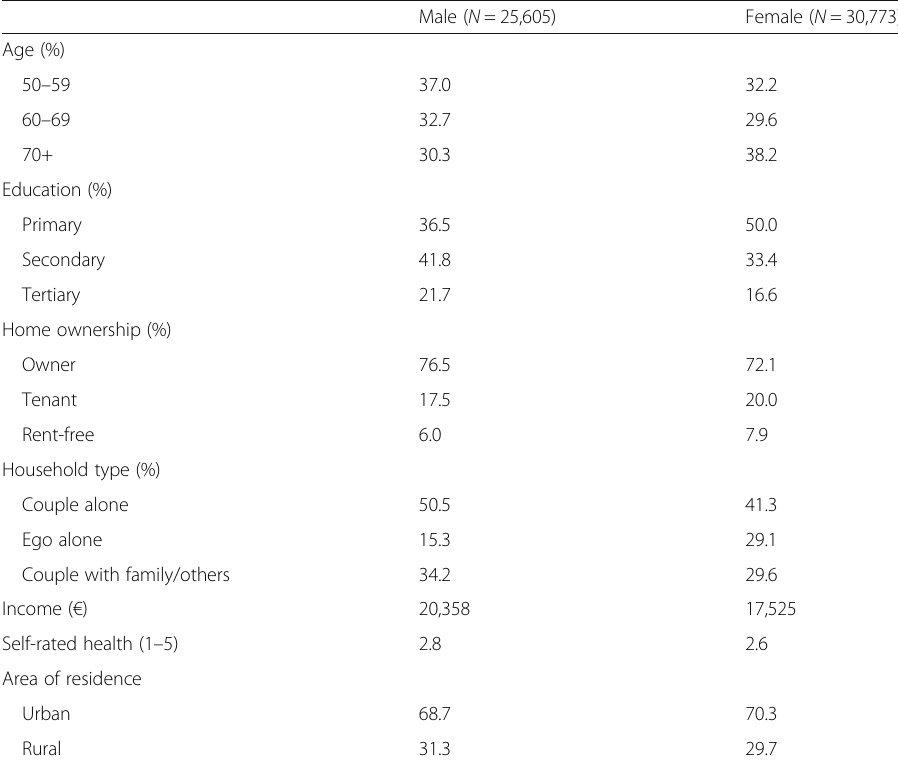
Table 5 Descriptive statistics for men and women. Means for continuous variables and percentages for categorical